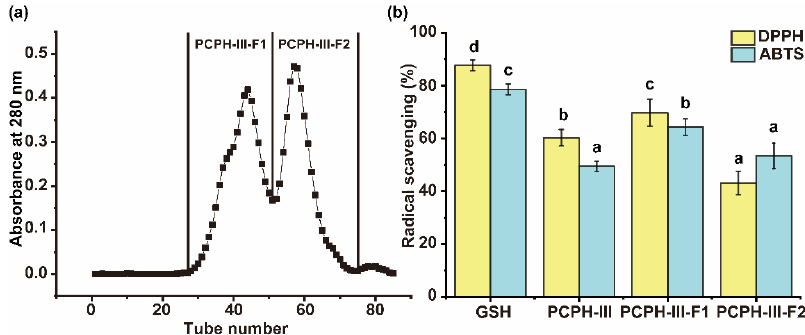
Figure 4. Antioxidant capacity of hydrolysates obtained by size-exclusion chromatogram. ( a ) Part of chromatograms of PCPH with MW < 3 kDa (PCPH-III) by Sephadex G-25 gel filtration. ( b ) DPPH radical scavenging capacity and ABTS radical scavenging capacity of pecan peptide part from G-25 gel filtration. Lowercase letter was used to exhibit statistical different: same letter indicated no significant difference, while different letters indicated significant difference ( p < 0.05). The data shown mean ± SD ( n =